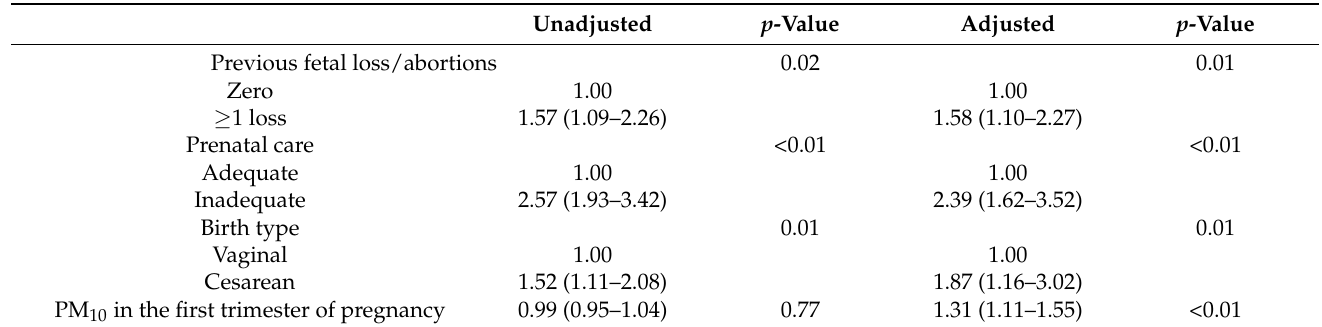
Table 5. Unadjusted and adjusted prevalence ratios (with 95% confidence limits) for pre-term birth among a coal mining area in Brazil.